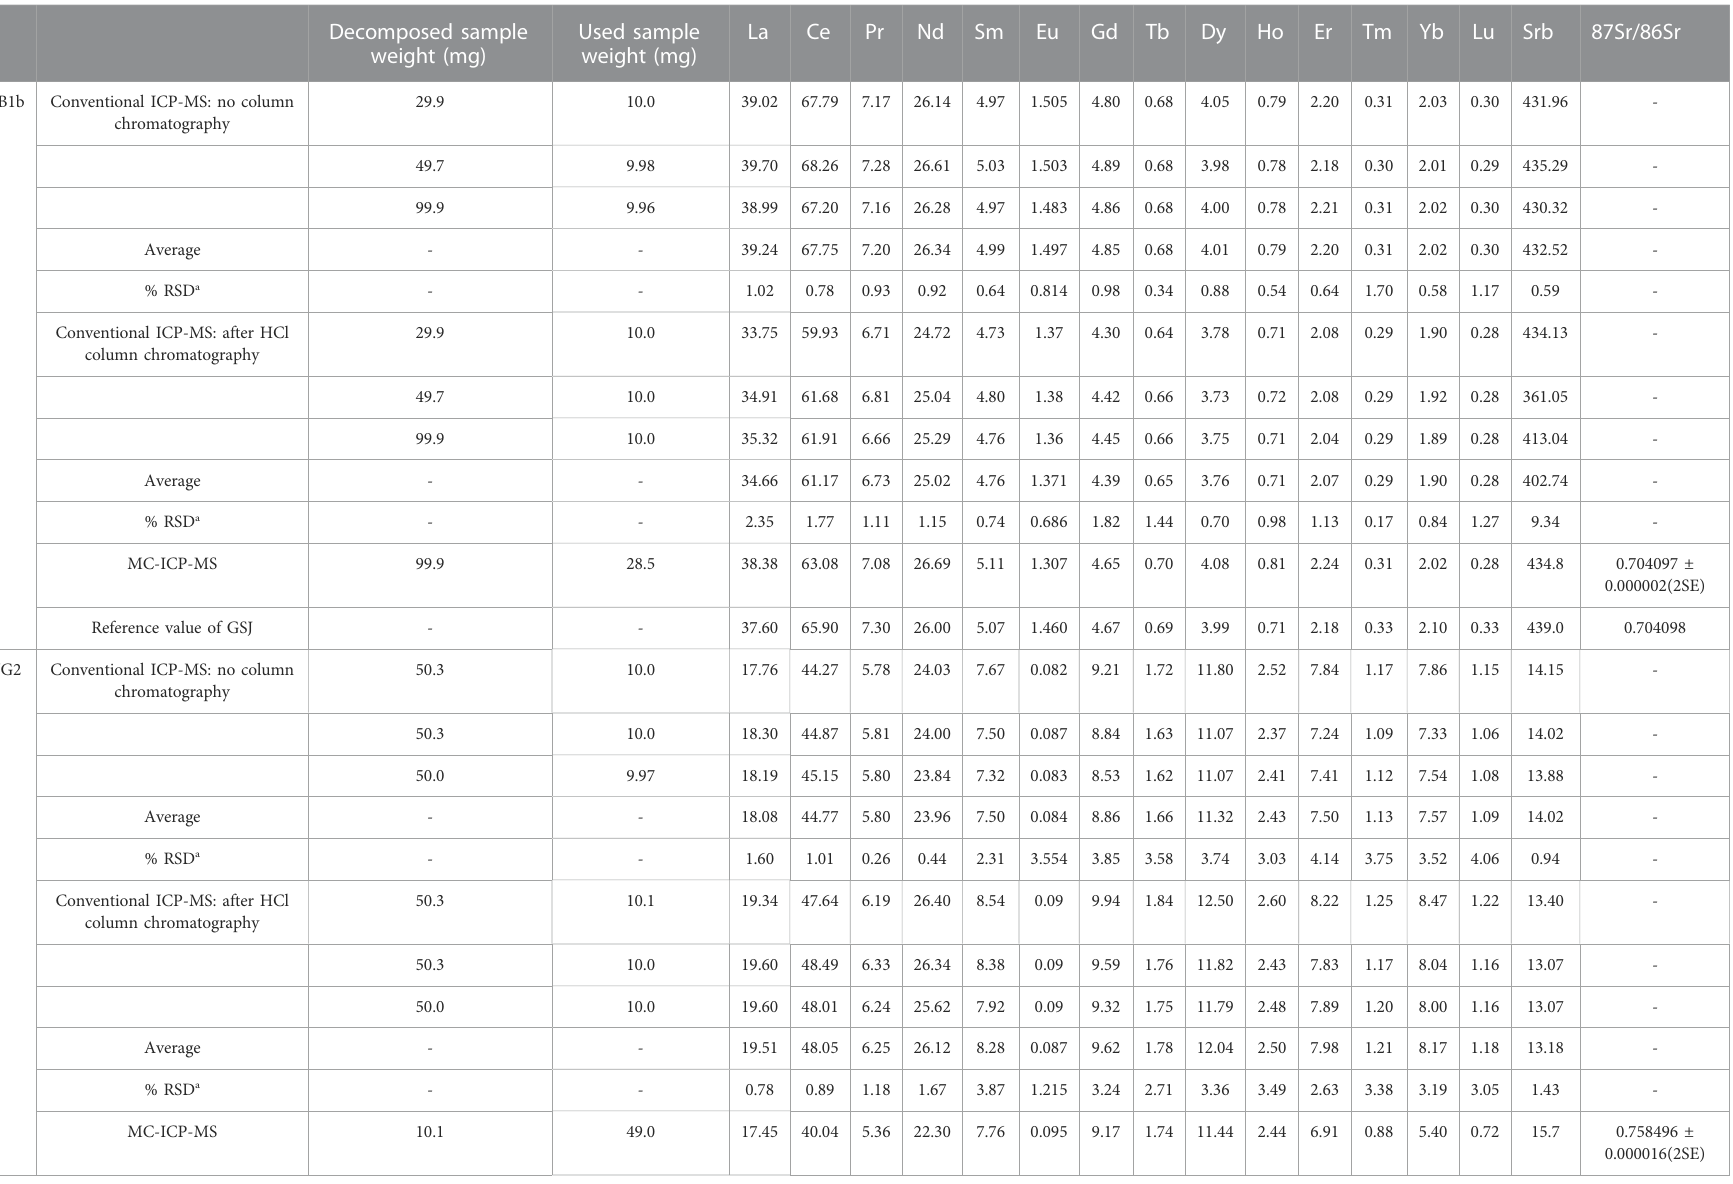
TABLE 6 Concentration ( μ g/L) of rare earth elements in JB1b, JG2, and JA1 Standard Rock